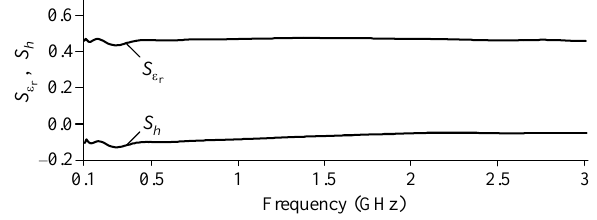
Fig. 7. Impact coefficients on the phase delay time of a system when changing: (a) the relative permittivity ɛ r ; (b) the height h of a dielectric substrate